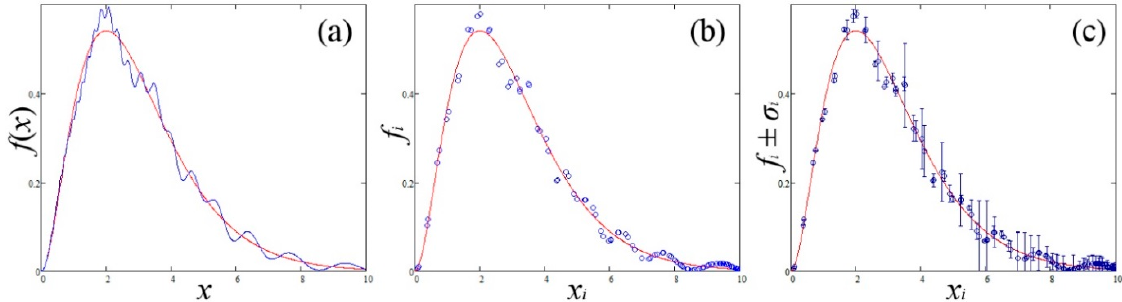
Figure 1. Fitting of a modeled function to ( a ) a more complicated curve, ( b ) discrete data with low noise and inconsiderable errors, and ( c ) data with random errors.